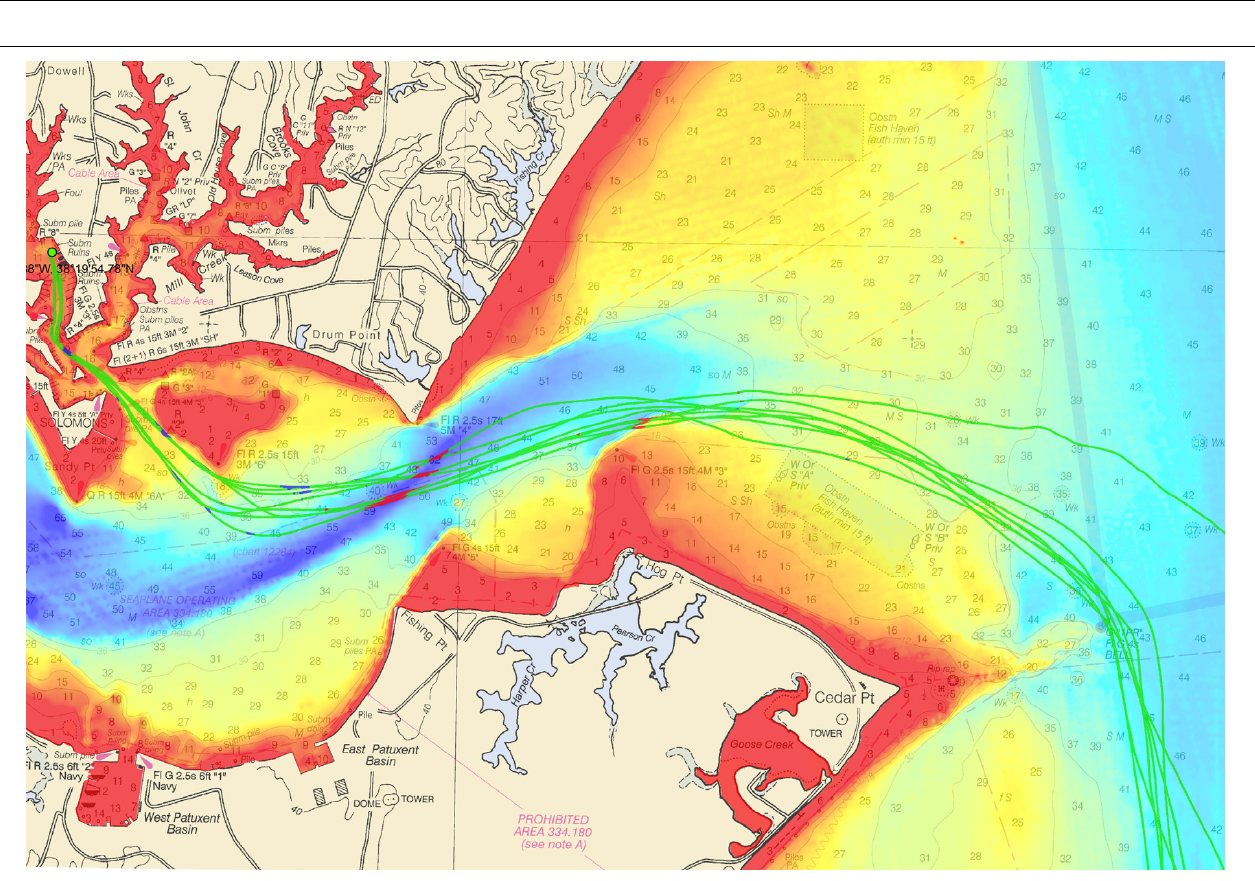
FIGURE 5 | NOAA’s Bay Hydro II crowdsourced bathymetry test tracks in green overlaid on multibeam survey data demonstrates how changes can be detected. Image courtesy of NOAA.